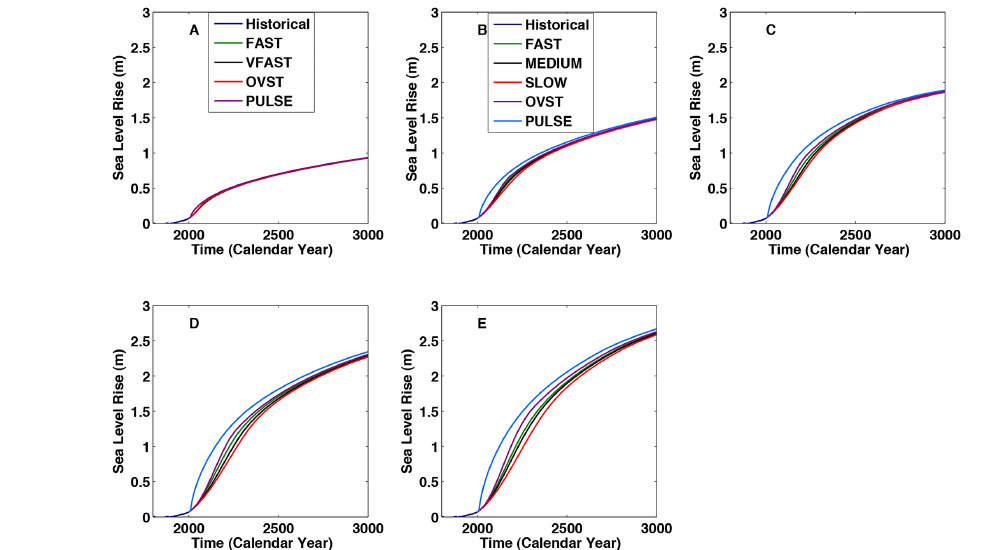
Figure 5. Global mean thermosteric sea level rise (relative to 1800) for the 1275–5275GtC scenarios. (a) 1275GtC scenarios, (b) 2275GtC scenarios, (c) 3275GtC scenarios, (d) 4275GtC scenarios, and (e) 5275GtC scenarios. Note: legend for (b) also applies to (c–e)